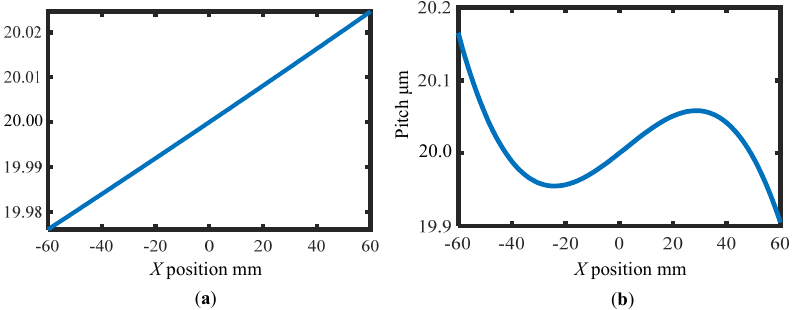
Figure 6. Simulated pitch variation of the VLS grating in the two cases. ( a ) Simulated pitch variation of the VLS grating in case one; ( b ) Simulated pitch variation of the VLS grating in case two.